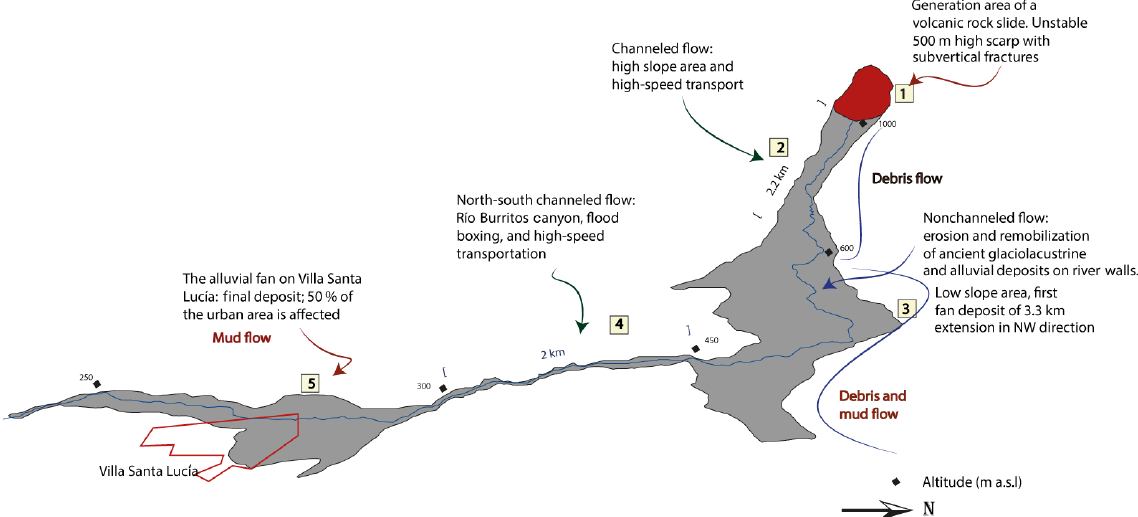
Figure 3. Flow trajectory scheme and details of the five key sections identified by Sernageomin and our